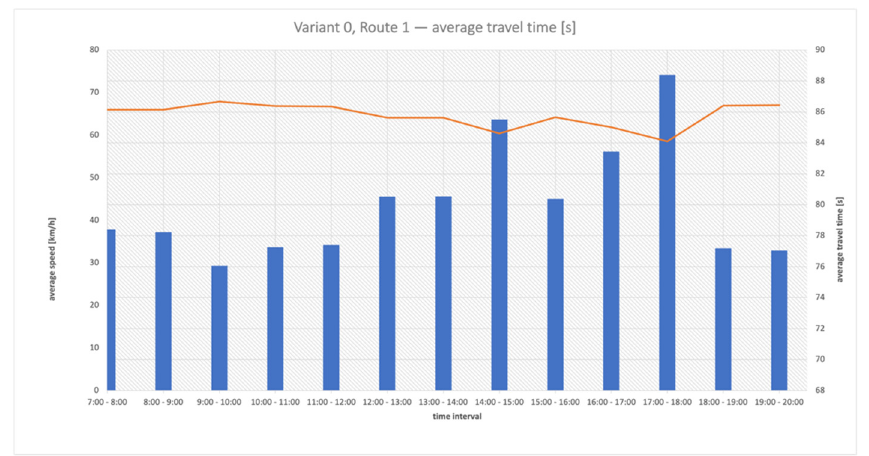
Figure 4. Variant 0; Section 1—average travel time [s].